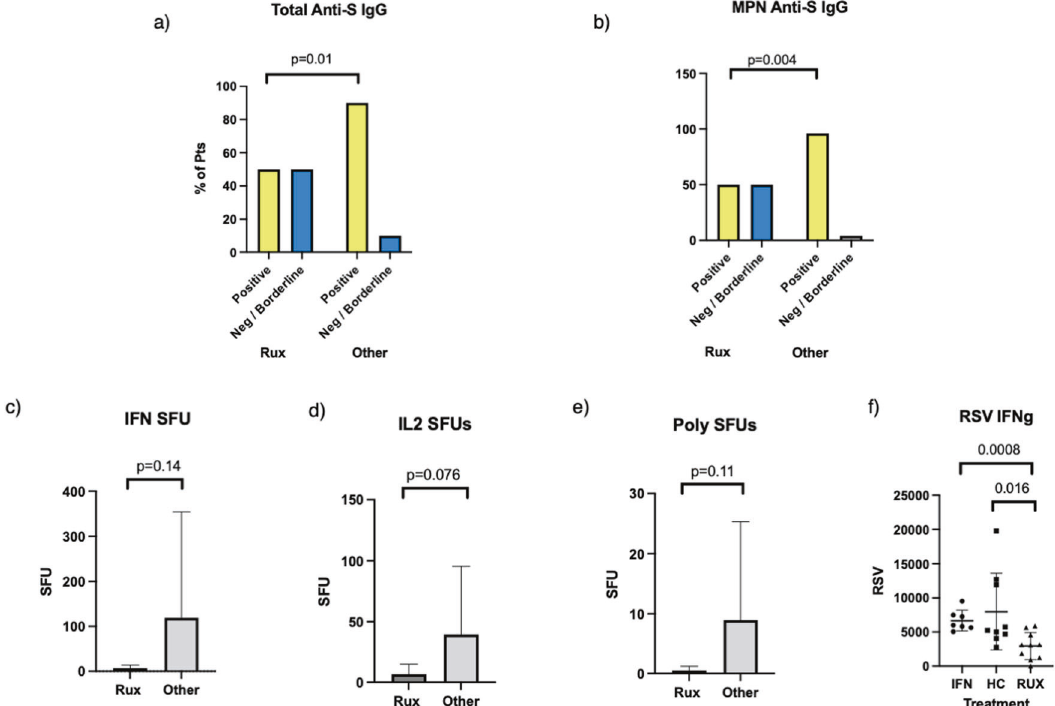
Fig. 1 Effect of Ruxolitinib treatment on antibody and T cell response to vaccination. Increased proportion of patients with negative or borderline positive response to vaccination in those taking ruxolitinib compared with ( a ) total cohort of other patients and ( b ) other patients with MPN diagnosis (Fisher ’ s exact test). c – e Reduced SFUs for ( a ) IFNg, ( b ) IL-2, and ( c ) polyfunctional cells in patients taking ruxolitinib compared with other patients (Independent samples t -test). f Reduced RSV in patients on ruxolitinib compared with MPN patients on other therapies (Independent samples t -test).